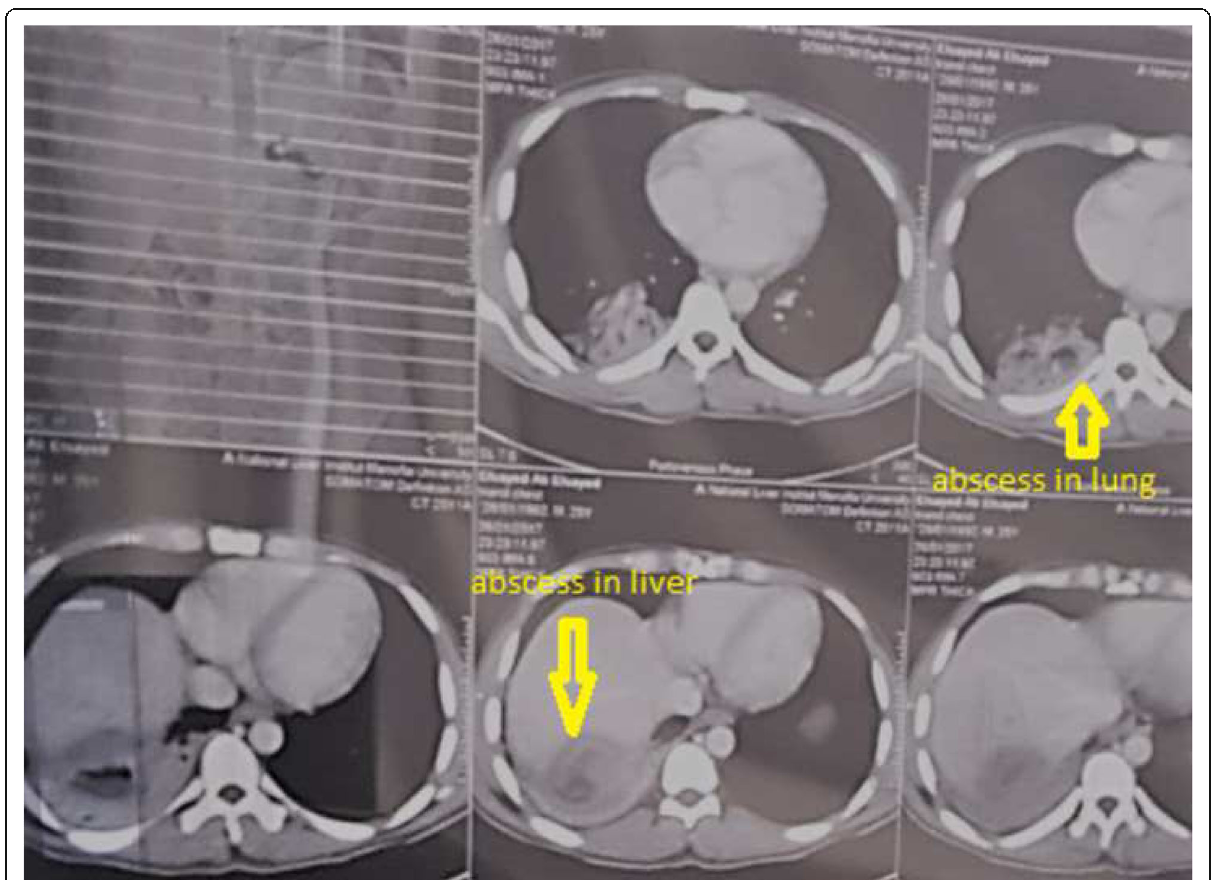
Fig. 1 CT of the lower chest and abdomen showing the abscess in the liver and lower